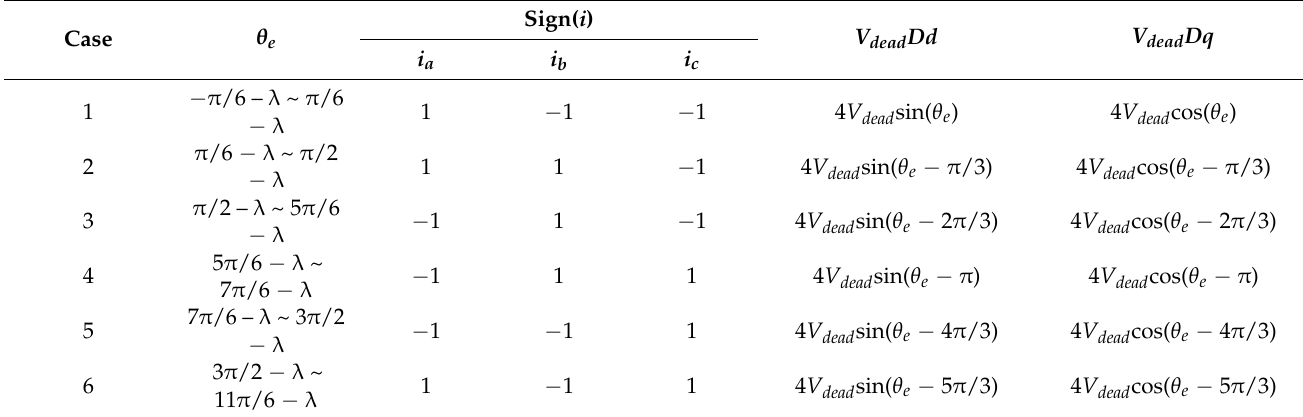
Table 1. Relationship of phase current polarities and dq -axis distorted voltage.